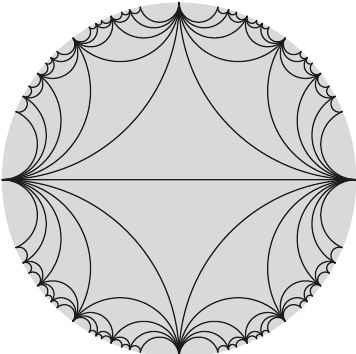
Figure 5 . The Farey tessellation.